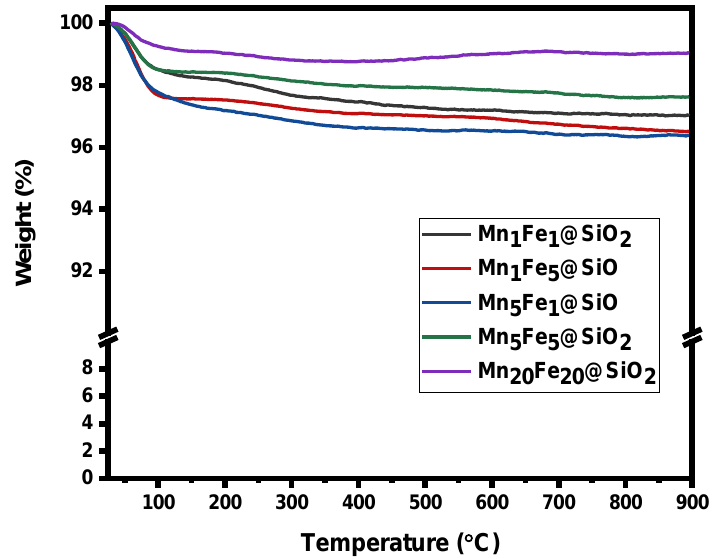
Figure 3. Thermogravimetric analysis TGA.